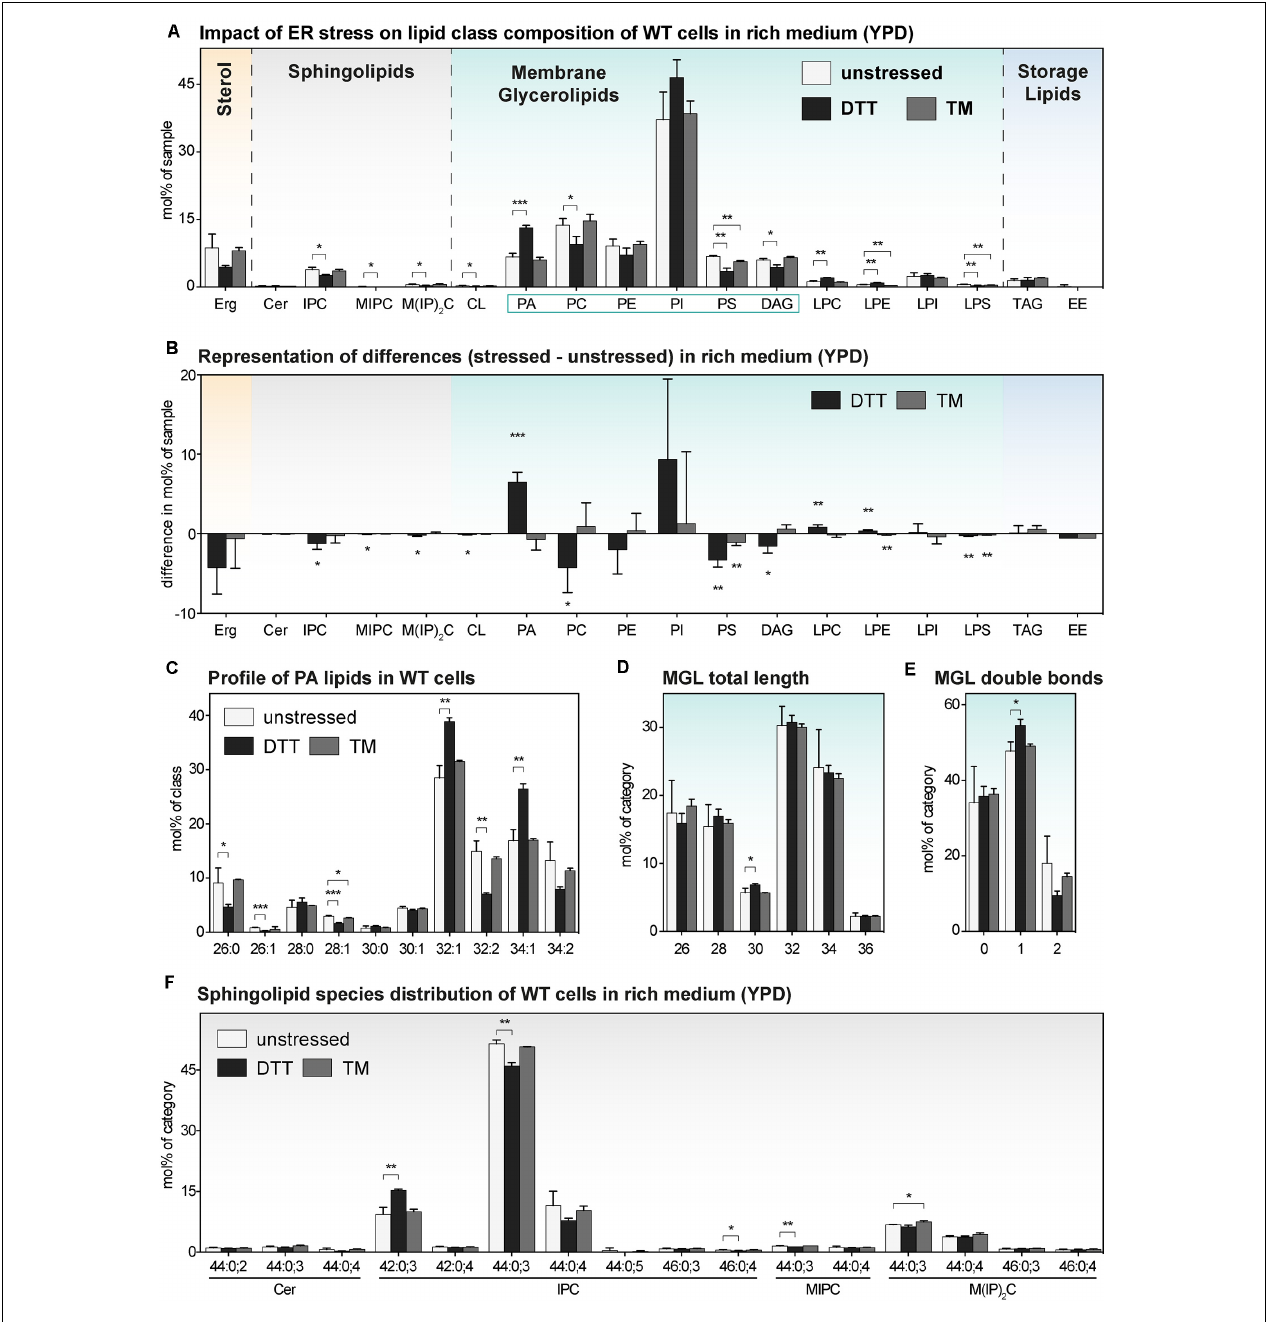
FIGURE 4 | The impact of proteotoxic stress on the lipidome of S. cerevisiae WT in rich medium. A single colony of the BY4741 WT strain was used to inoculate a preculture in rich (YPD) medium. After overnight cultivation for 21 h, a fresh culture was inoculated to an OD 600 of 0.1 and then cultivated to an OD 600 of 0.80 ± 0.05. The cells were then either left untreated (white bars), stressed by the addition of either with 8 mM DTT (black bars) or 1.0 µ g/ml TM (gray bars). After one additional hour of cultivation, 20 OD equivalents of these cells were harvested and analyzed by lipid mass spectrometry. (A) Lipid class composition in mol% of all quantified lipids in the sample organized by lipid categories. (B) The difference in lipid class abundance in stressed minus unstressed cells highlights the impact of DTT (black) and TM (gray) on the cellular lipid composition in rich medium. The difference in abundance in mol% was calculated by subtracting the abundance in unstressed cells from the abundance in either DTT- or TM-stressed cells under consideration of error propagation. (C) Profile of PA lipids in mol% of the class. (D) Total length of lipids in a sub-category of MGLs (PA, PC, PE, PI, PS, DAG). The total length is given as the sum of carbon atoms in both fatty acyl chains in mol% of this sub-category. (E) Total number double bonds in a sub-category of MGLs (PA, PC, PE, PI, PS, DAG) is given as the sum of double bonds in both acyl chains and represented in mol% of this sub-category. (F) Profile of sphingolipids in mol% of this category. The least abundant species are omitted for clarity. Each bar represents the average ± SD from n = 3 independent experiments. Statistical significance was tested by an unpaired two-tailed t -test using GraphPad Prism, * p < 0.05, ** p < 0.01, *** p < 0.001.